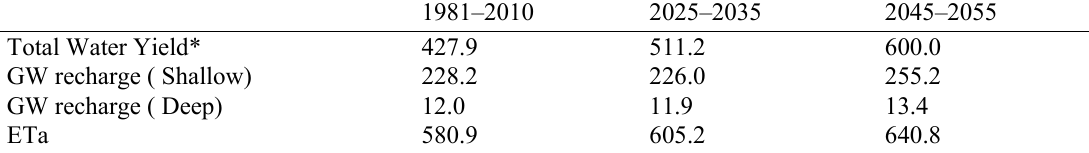
Fig. 4 Sub-catchment scale precipitation changes and water yield for three time periods. Table 3 Average values of key hydrological variables for the three time periods in